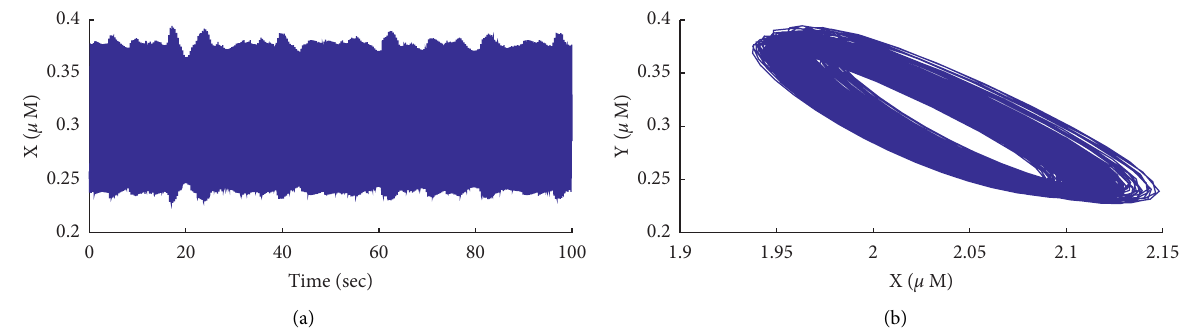
Figure 2: Original chaotic Ca 2+ oscillation in coupled model (6) of nonexcitable cell without control constraints at r � 0.95. (a) The respective time course of variable X with controlling rate parameters k c1 � 0, k c2 � 0. (b) 2D projection of the trajectory in X , Y phase space with controlling rate parameters k c1 � 0, k c2 � 0.